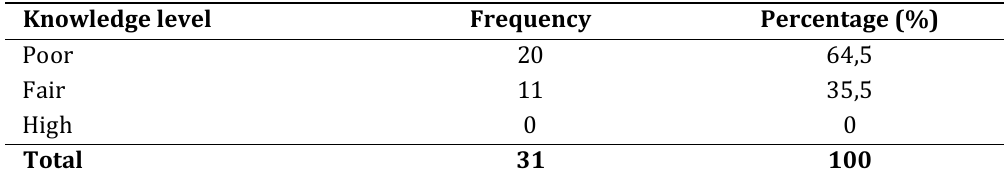
Frequency Distribution of Respondents' Knowledge Prior to Health Education Interventions (n=31) Knowledge